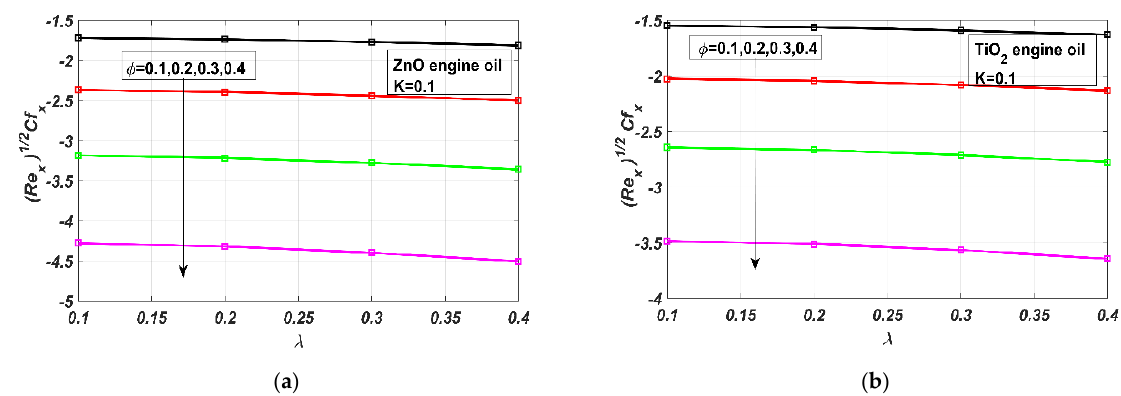
axis. Figure 8 described the effect of rotation parameter on Nusselt number.